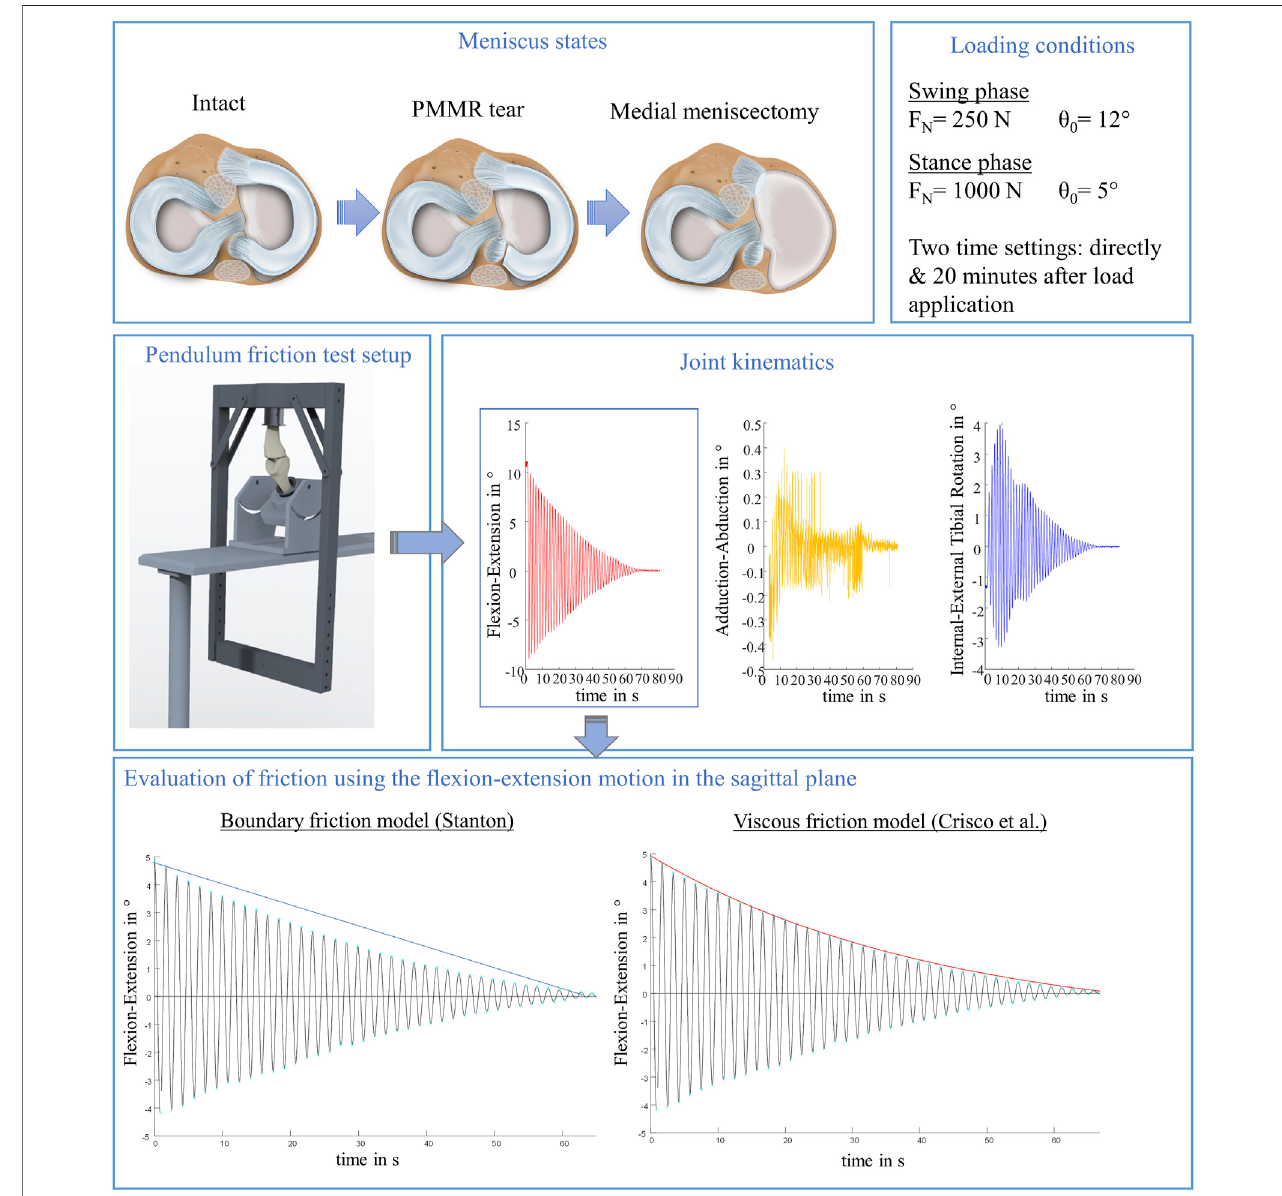
FIGURE 1 | Schematic overview of the study design. In total, three meniscus states were tested to examine the in fl uence of the menisci on initial whole knee joint friction:intact,withposteriormedialmeniscusroottear(PMMRtear)andaftermedialmeniscectomy.Eachmeniscusstatewastestedundersimulatedswingandstance phase conditions derived from an ovine gait cycle (Taylor et al., 2006; Taylor et al., 2011), each under two time settings: directly following loading the joints and after 20 min resting under the axial load using a passive pendulum friction testing device. Joint kinematics were recorded using a motion capturing system. The fl exion- extensionmotioninthesagittalplanewasusedtocalculatewholejointfrictionbyapplyingaboundaryfrictionmodel(Stanton,1923)andaviscousfriction model(Crisco et al., 2007).